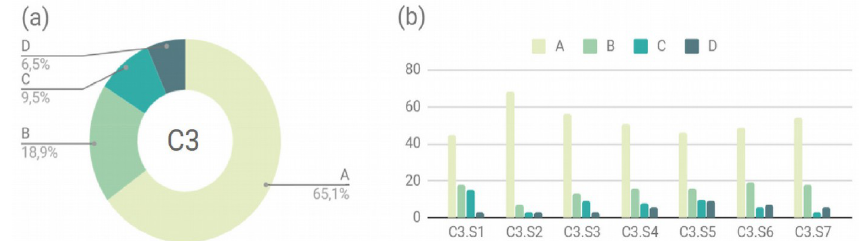
Figure 7. Student assessment of category C3. Challenges (a) as a whole and (b) for each question. Table 3 shows the coding of the